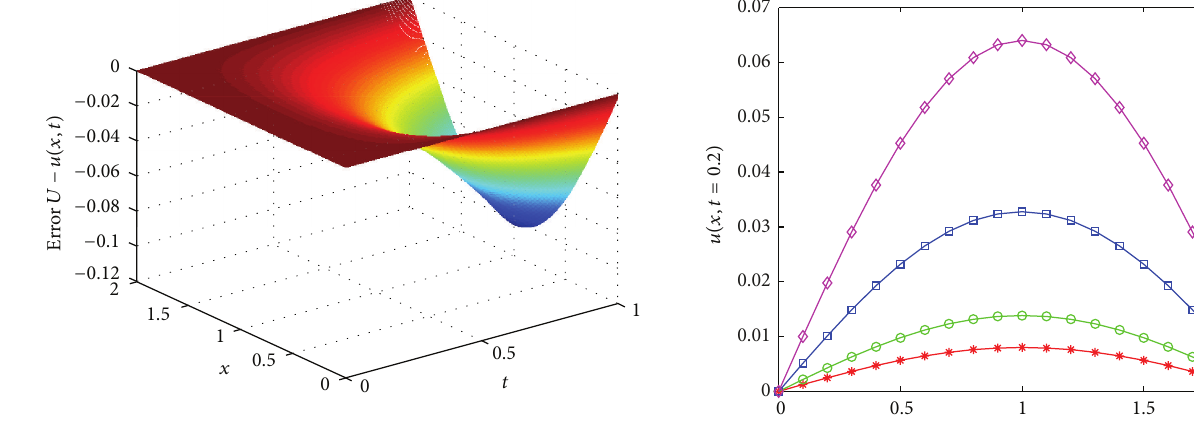
= O (𝜏 2 + ℎ 4 ) because ̂𝑅 𝑘 𝑙